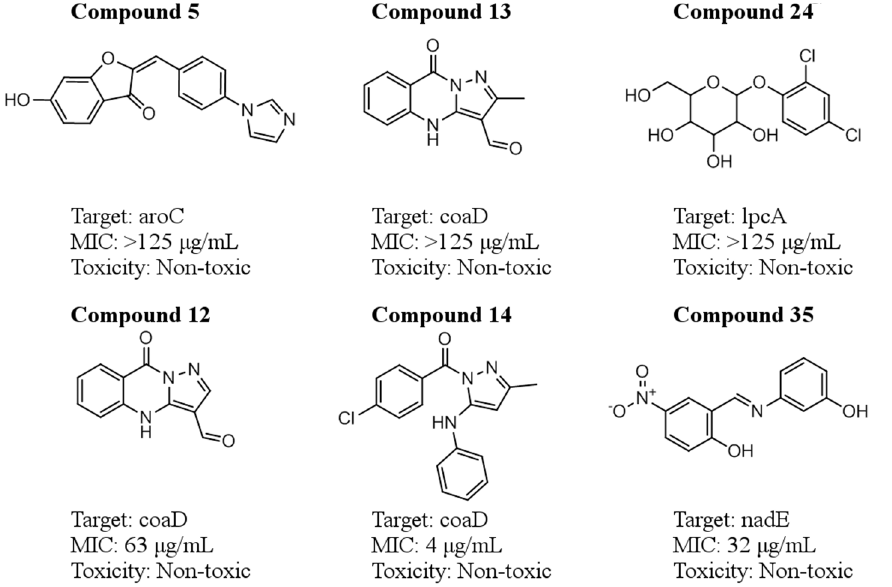
Figure 4. Potency and toxicity of identified antimicrobials against F.tularensis . Compound ID, chemical structure, putative target, minimum inhibitory concentration (MIC), and toxicity for each of the active antimicrobials identified in this study.